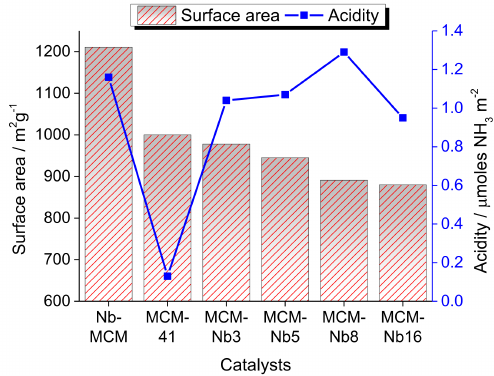
Figure 22. Effects of Nb load on the surface area and acidity of the MCM-supported catalysts. MCM- Nb3, MCM-Nb-5, MCM-Nb8, and MCM-Nb16, where the number in the names represents the wt%